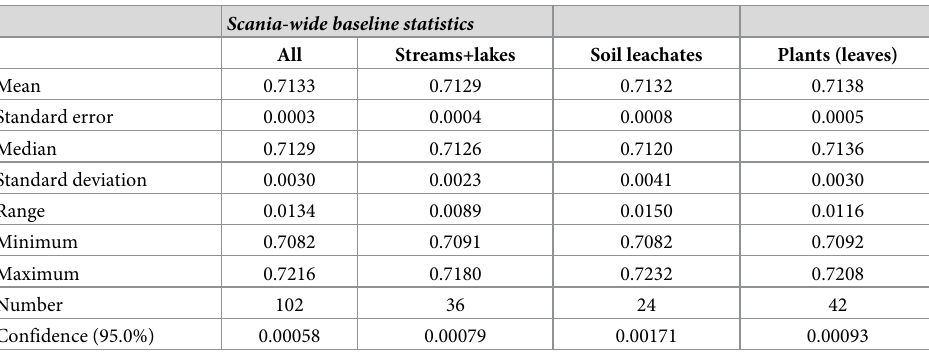
Table 3. Descriptive statistics of bioavailable 87 Sr/ 86 Sr ratios from